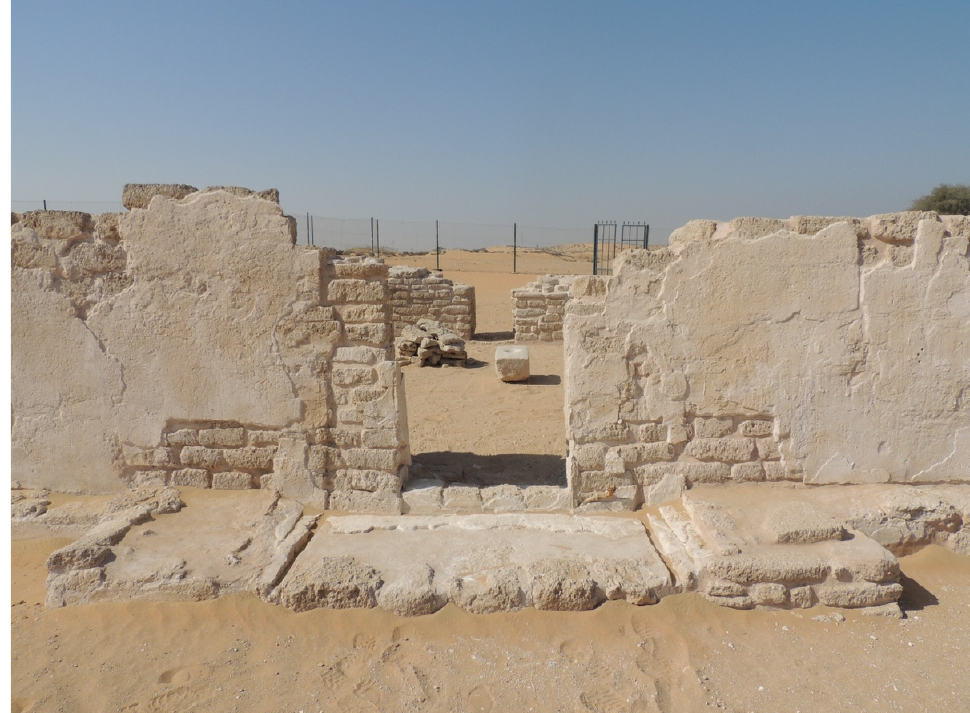
Figure 2. Entrance to the temple (note the pedestals and gypsum).